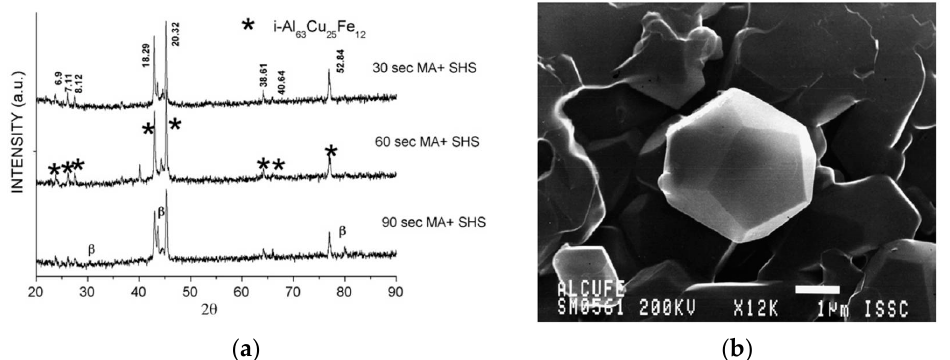
Figure 2. X-ray diffraction (XRD) patterns of the products of self-propagating high-temperature synthesis in a Al-Cu-Fe powder mixture, indicating the formation of Al 63 Cu 25 Fe 12 quasicrystals, the time of HEBM (or mechanical activation, abbreviated as MA in the image) was 30, 60 or 90 s ( a ). Morphology of the synthesized quasicrystals, secondary electron (SE) image ( b ). Reprinted from [21], Copyright (2007), with permission from Elsevier.